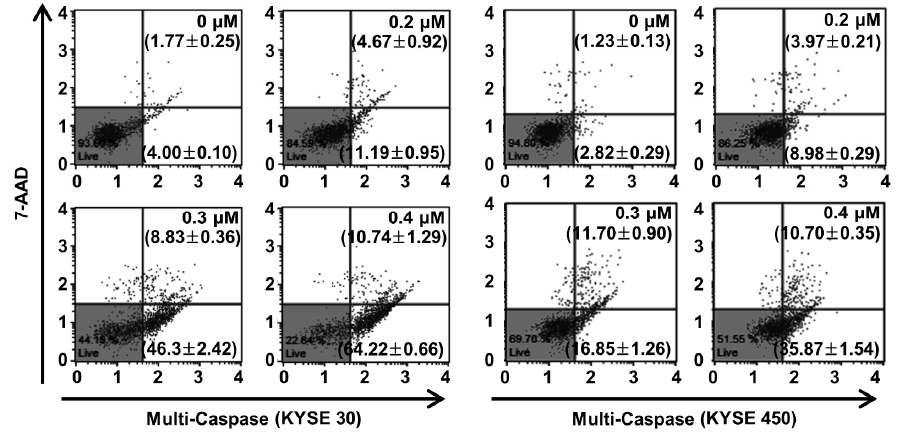
Figure 6. PPT treatment enhanced the multi-caspase activity in ESCC cells. The cells were treated with the indicated concentrations of PPT (0.2, 0.3, and 0.4 µM) or DMSO. The activation of multi-caspases